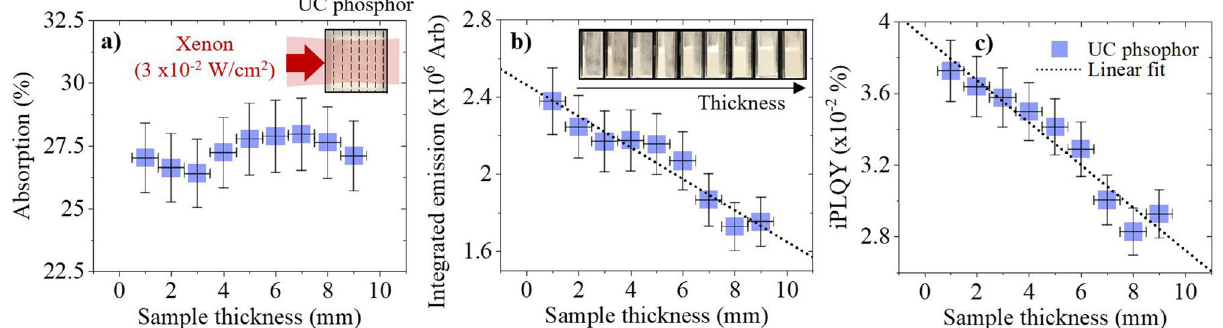
Figure 5. β-NaYF 4 :(18%)Yb 3+ ,(2%)Er 3+ phosphor is measured at various sample thicknesses using 980 nm Xe lamp excitation (blue square). The following is presented against sample thickness: ( a ) absorption, with an inset depiction of the excitation conditions inside each sample, ( b ) integrated emission (500–700 nm) with inset pictures of each sample’s side-profile, and ( c ) iPLQY (500–700